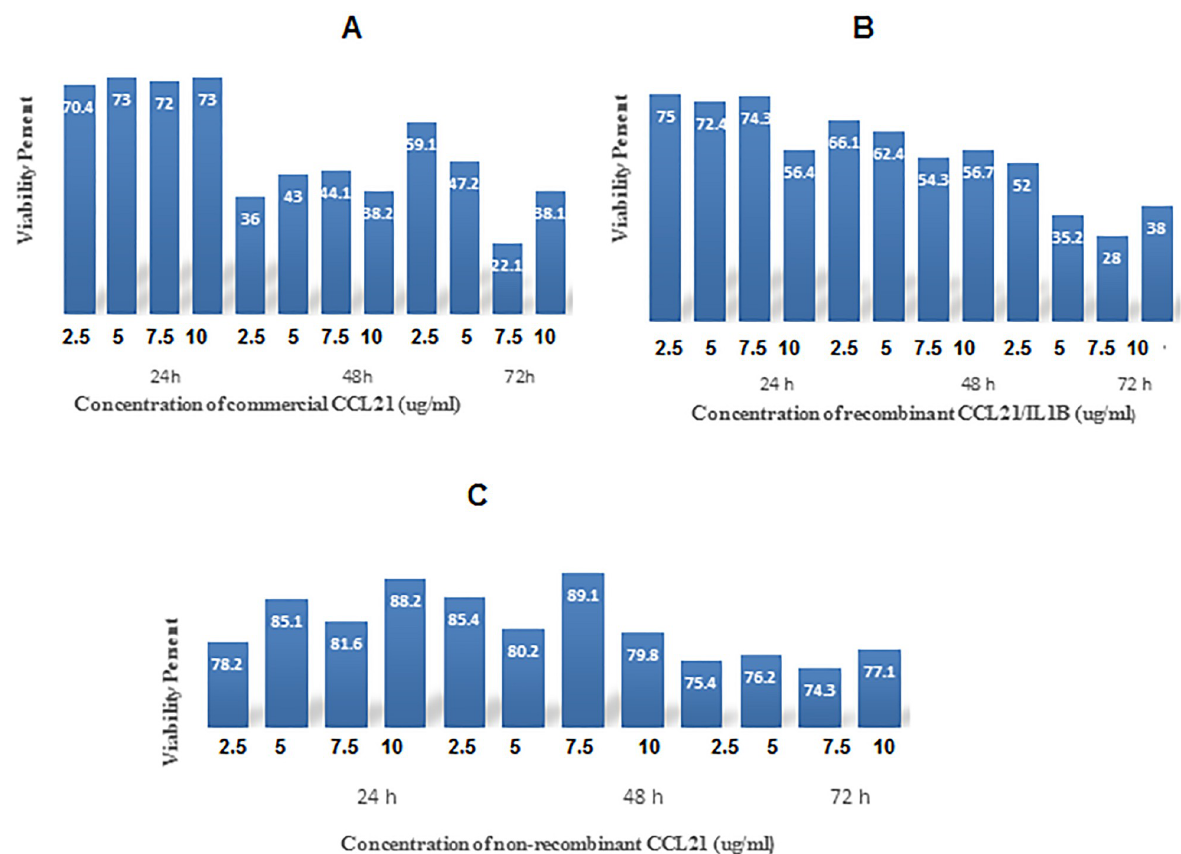
Fig 7. Cytotoxicity analysis of recombinant, commercial, and non-recombinant CCL21 on MCF7 cell line at 24, 48, and 72 hours after incubation. A : Cytotoxicity of recombinant CCL21 protein in comparison with the control group at different concentrations (2.5, 5, 7.5, and 10 μ g/ ml) on MCF7 cancer cells: at 7.5 μ g/ml, the survival rate of cancer cells incubated with the purified recombinant CCL21 protein was 22.1% lower in comparison with DMEM medium as the control treatment (MTT assay was performed during 3 consecutive days with 3 different concentrations of recombinant CCL21). B : Cytotoxicity of commercial CCL21 protein at different concentrations (2.5, 5, 7.5, and 10 μ g/ml) on MCF7 cancer cells was 28% lower in comparison with the control treatment, Also The IC50 of CCL21/IL1 β plant recombinant protein against MCF7 cells was 3.86 μ g/ml and IC50 of commercial CCL21 was 0.315 μ g/ml. C : At a concentration of 7.5 μ g/ml, survival rate of cancer cells incubated with non-recombinant protein was 74.3% lower compared to DMEM as control. CCL21/IL1 β recombinant protein and the non-recombinant protein. Therefore, we estimated that approximately 138 cells migrated within 24 hours (Fig 8B). For the other group, FBS 10% was placed (2.5 μ g/mL) in the left well as the positive control, and DMEM medium as the nega- tive control (2.5 μ g/mL) in the right one, as depicted in Fig 8C. The result was the migration of 158 cells after 24 hours to the left well. The last group had two negative controls: one well was filled with non-recombinant protein, and the other with DMEM medium. Only a few cells (15 cells) were observed in each well, implying that neither chemoattractant factor had absorbed the cells (Fig 8D). An approximate quantification of the number of migrated cells was achieved using the Heit and Kubes method [48]. In this analysis, the number of migrated cells in the dis- tance of wells containing cells and those containing chemoattractants was deduced from the number of cells that migrated between the wells containing cells and the wells containing non- absorbent material.Consequently, as shown in Fig 8, the number of monocytes moving toward the adsorbent substance was higher than that toward the non-adsorbent material, and the che- motaxis of the recombinant protein was estimated to be about 91% (Table 2). This modified